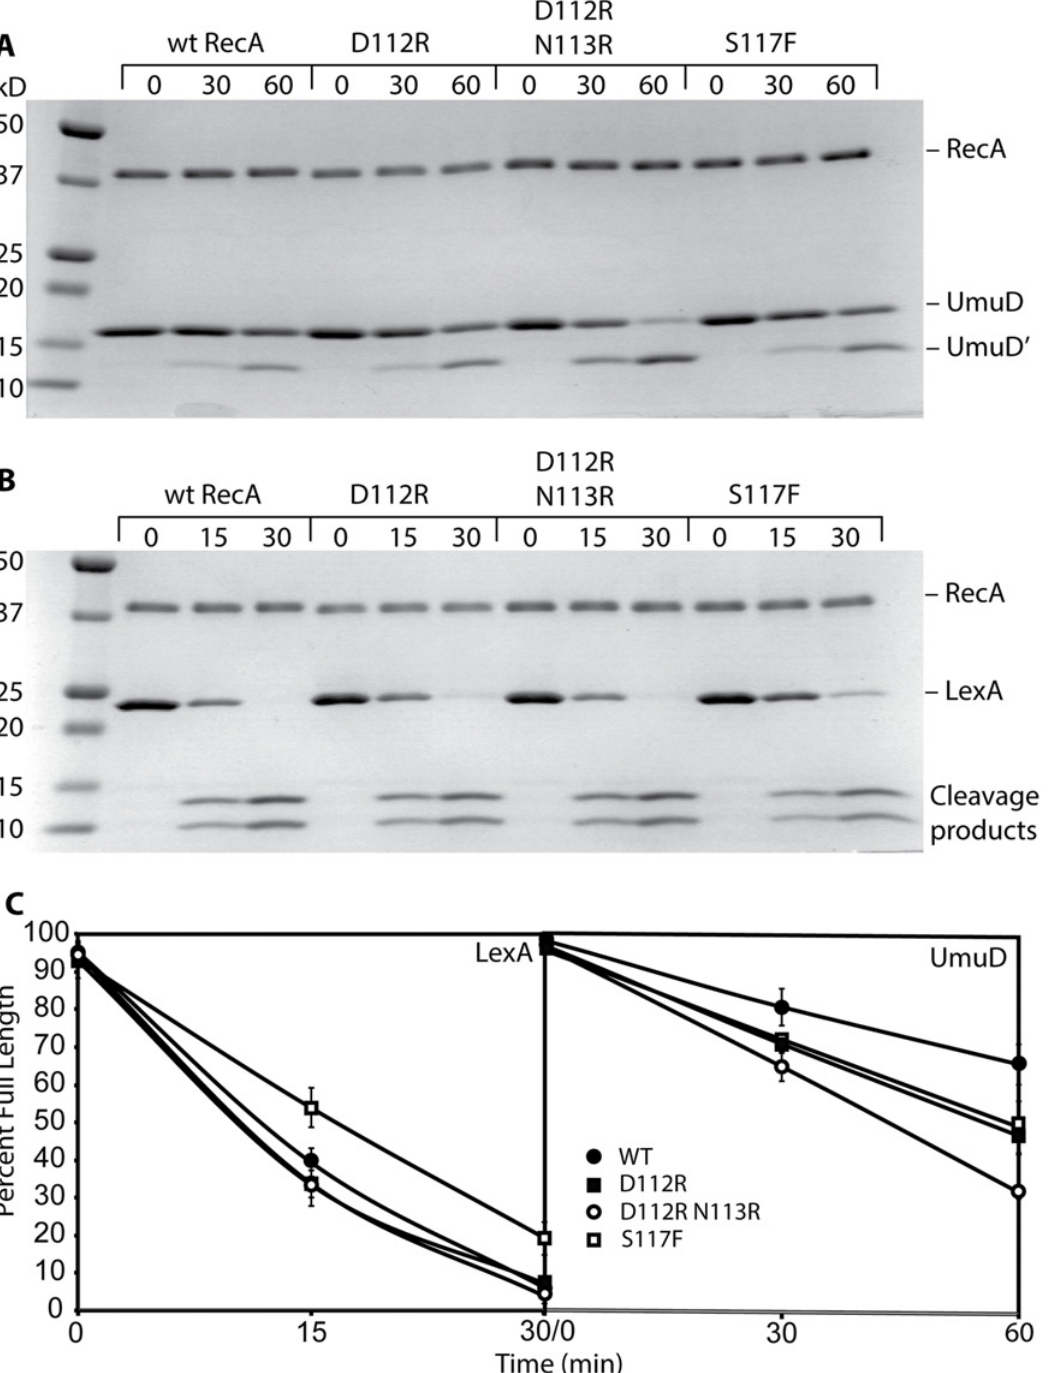
Fig 4. RecA D112R and RecA D112R N113R promote autocatalytic cleavage of LexA and UmuD in vitro . Reactions were carried out as described in Methods. At least four repeats with all RecA variants were conducted. Representative gels are shown. (A) Cleavage of UmuD protein. Reactions containing 5 μ M of M13mp18 cssDNA, 3 μ M RecA, 3 mM ATP γ S, and 8 μ M UmuD were incubated at 37°C for 0, 15, and 60 minutes and visualized by staining with Coomassie blue. (B) Cleavage of LexA protein. Reactions containing 5 μ M of M13mp18 cssDNA, 3 μ M RecA, 3 mM ATP γ S, and 8 μ M LexA were